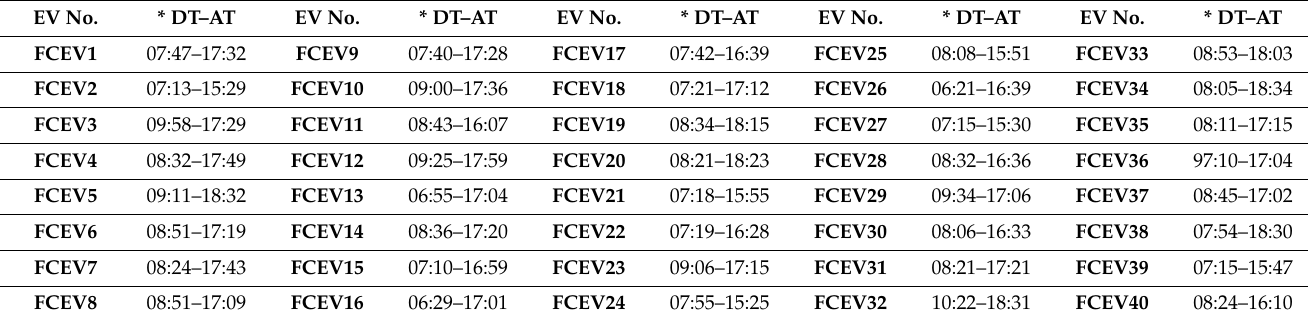
Table 2. Data of FCEV